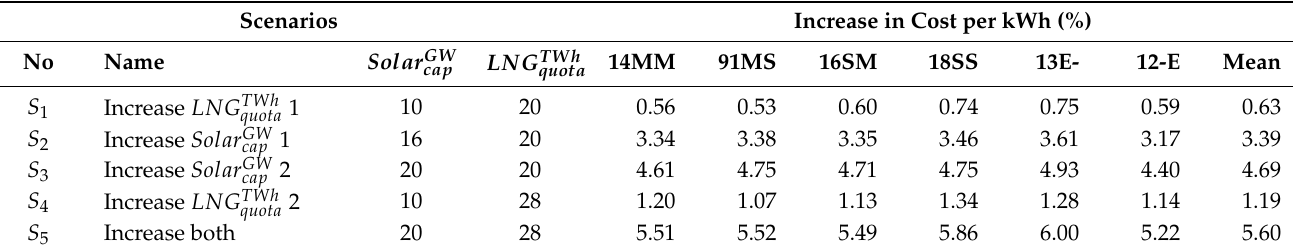
Figure 18. Levelized generation cost and CO 2 emissions for the warmer year (16SM) scenario. The CO 2 emissions (abscissa) are formatted in decreasing order to emphasize the trend. S 0 reflects the current situation, and S 1 – S 5 are the potential future scenarios. Table 10. Cost increase from the reference scenario.